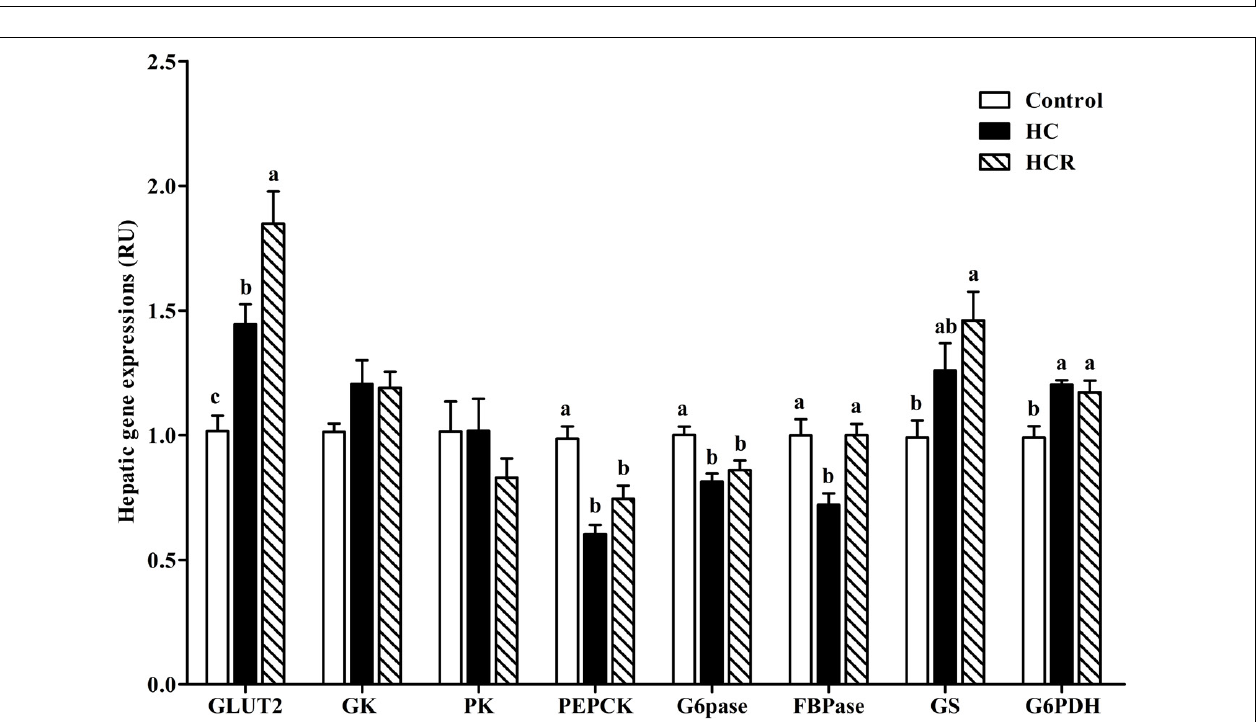
FIGURE 3 | Relative expressions of the genes involved in energy sensing in the liver of blunt snout bream fed different experimental diets. Data are referred to the values (relative units, RU) obtained in fish fed the control diet. Values were normalized with the transcription of EF1 α . Each data represents the mean of four replicates. Bars assigned with different letters are significantly different ( P < 0.05). Control, diet with 30% carbohydrate level; HC, diet with 41% carbohydrate level; HCR, diet with 41% carbohydrate and 0.04% resveratrol.